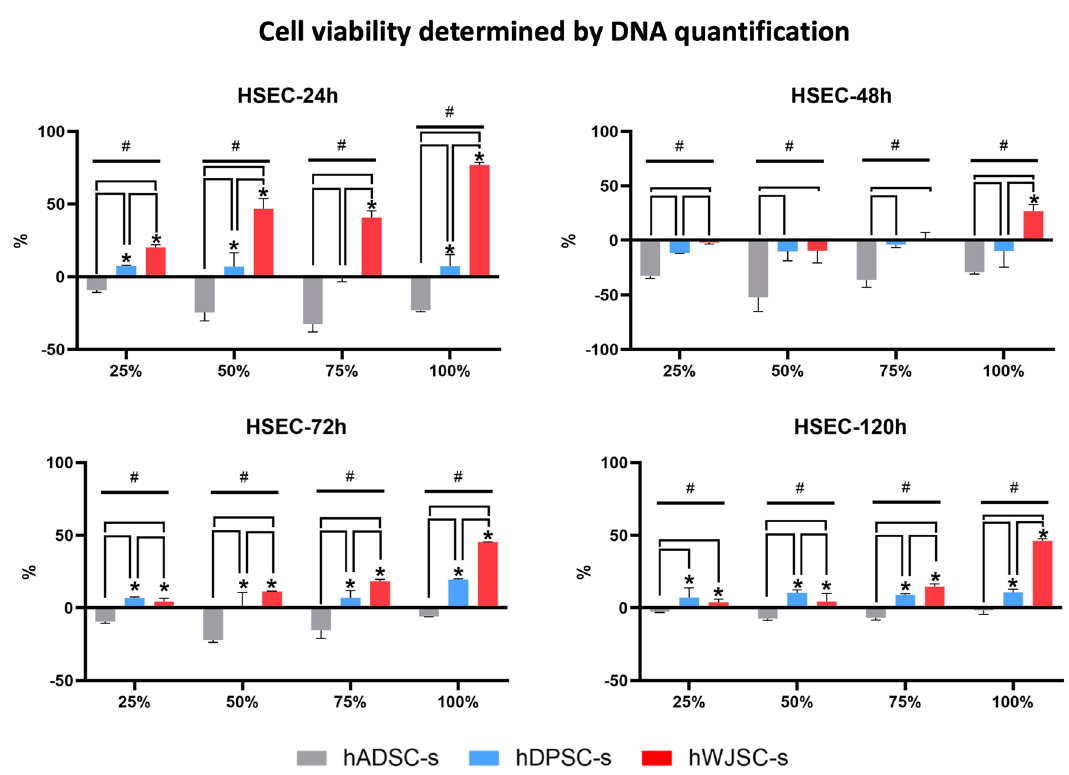
Figure 3. Analysis of cell viability as determined by DNA quantification in HSEC exposed to different types (hADSC-s, hDPSC-s and hWJSC-s) and concentrations (25%, 50%, 75%, 100%) of secretome after 24, 48, 72 and 120 h of follow-up. Results were normalized with respect to positive controls (in the 0 line/row) and are expressed as the percentage increase in cell viability compared to positive controls. Standard deviations are shown as error bars. hADSC-s human adipose-derived MSC secretome, hDPSC-s human dental pulp MSC secretome, hWJSC-s Wharton’s jelly MSC secretome. Statistically significant increases compared to controls are labeled with an asterisk (*), and comparisons between types of secretome are grouped with a horizontal square bracket. Statistically significant differences detected with the Kruskal–Wallis test are labeled with